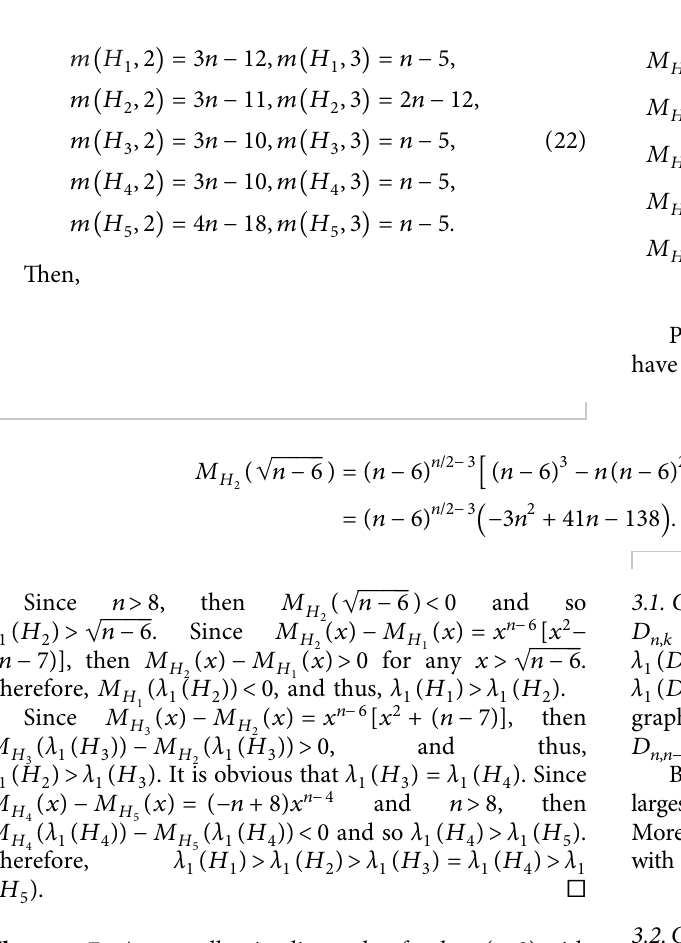
Figure 7: Five graphs in Theorem